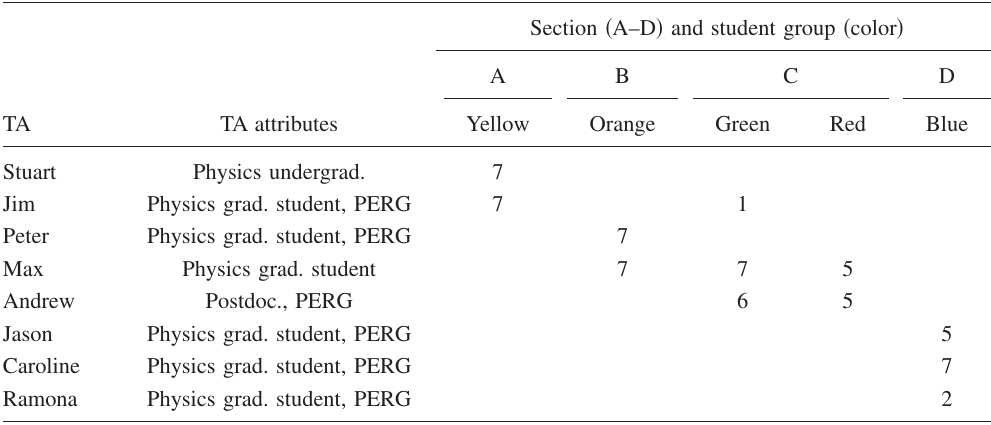
TABLE I. Teaching assistant attributes, tutorial sections, and student groups. The numbers indicate how many weeks each TA was observed teaching the indicated